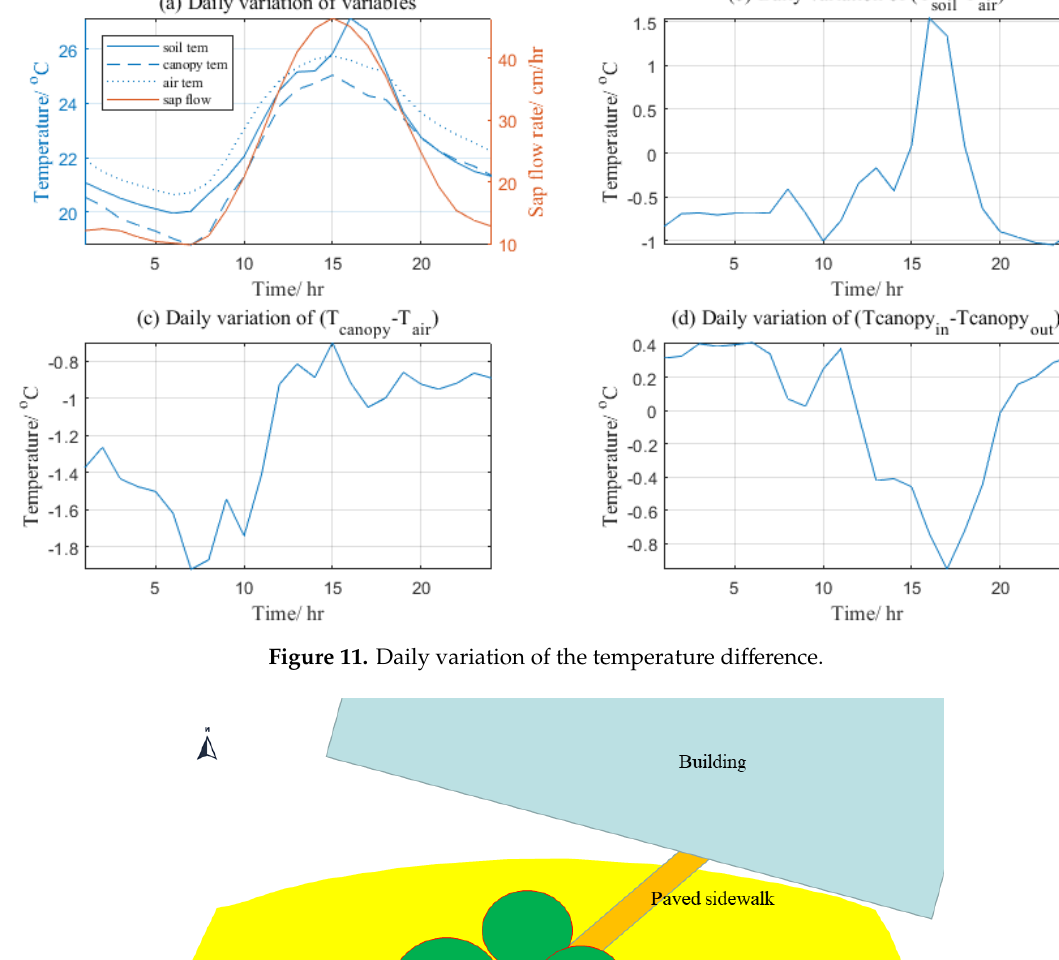
Figure 11. Daily variation of the temperature difference.